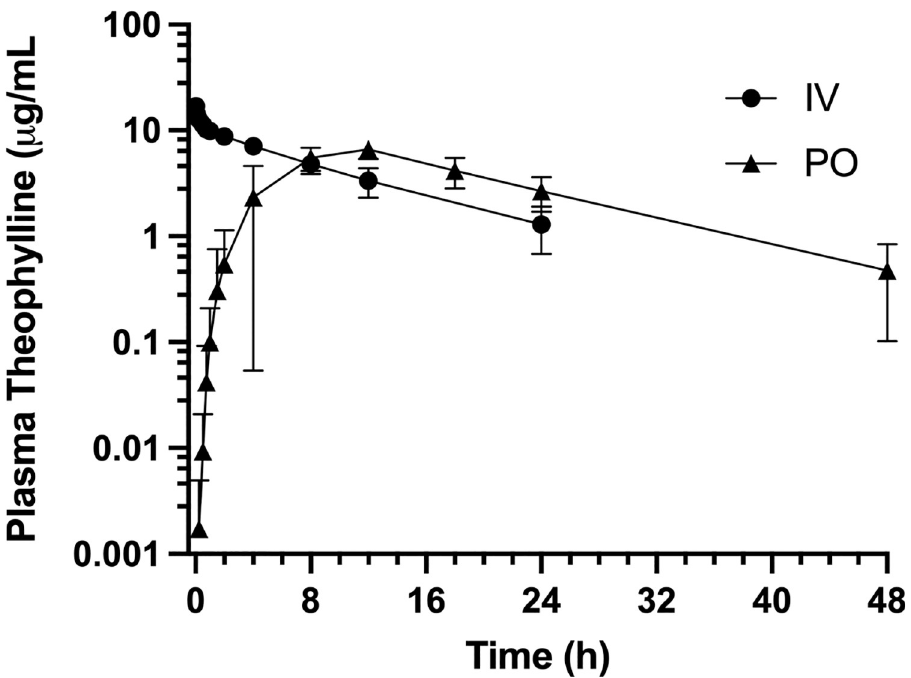
Fig 1. Concentration-time curves. Concentration-time curves of intravenously administered aminophylline (11 mg/ kg) and orally administered OFT. Circles represent IV aminophylline and triangles represent PO OFT. (8.75 ± 2.97 h vs. 9.20 ± 2.87 h, p = 0.472). Regardless, twice daily administration appears to be